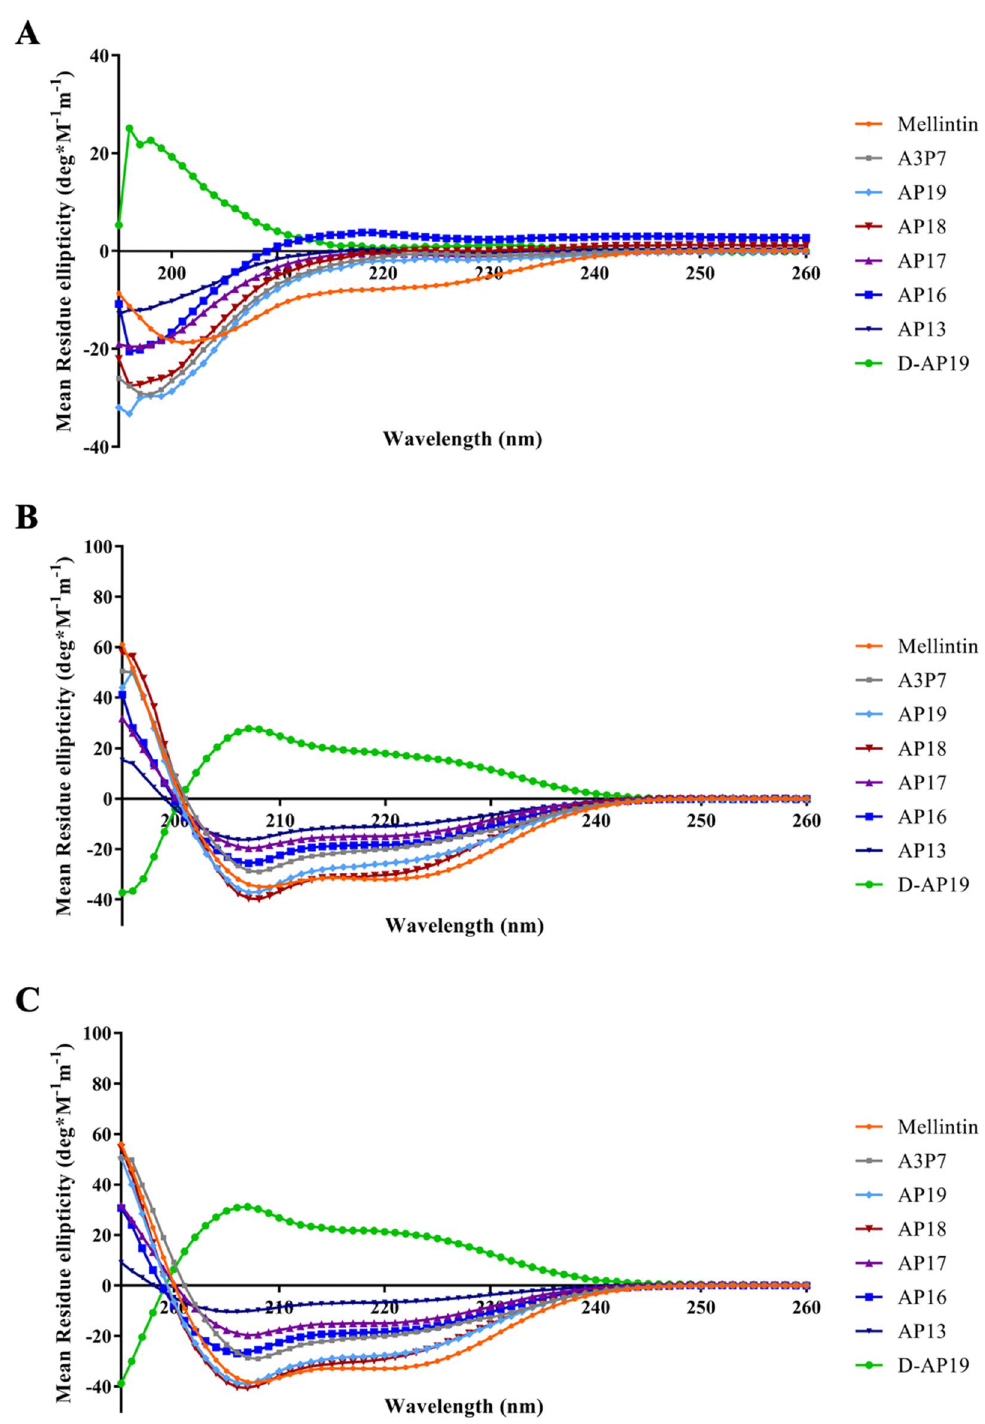
Figure 3. The circular dichroism spectra of melittin, A3P7, AP19, AP18, AP17, AP16, AP13 and D-AP19 in PBS ( A ), 30 mM SDS micelles in PBS ( B ), and 50% (v/v) TFE in PBS ( C ). Peptides were dissolved in each solution, filled in a 0.1 cm path length rectangular quartz cell and measured at 25 °C by Jasco-815 spectropolarimeter. Three scans of CD spectra were analyzed in the wavelength range of 190 to 260 nm at scanning speed of 10